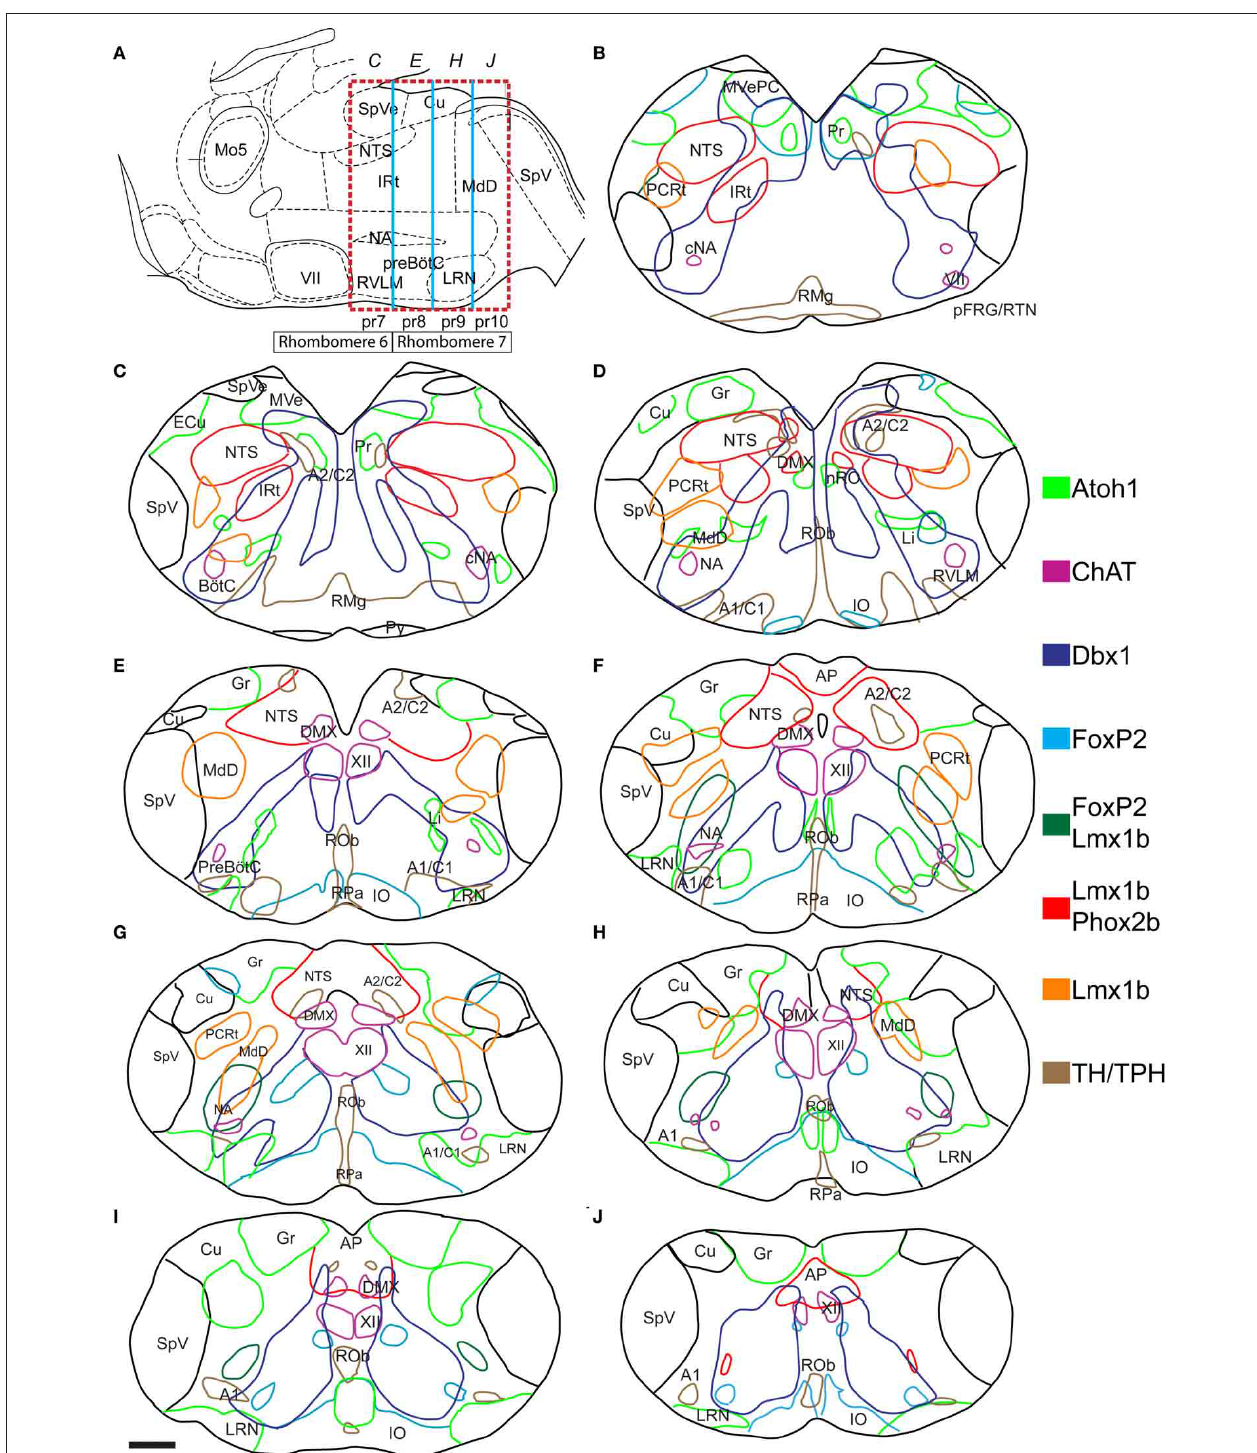
FIGURE 2 | Atlas of reticular formation developmental origin in neonate mouse medulla. (A) Mid-sagittal cartoon showing approximate region of mapping (red dashed box). Boxes below hindbrain indicate rhombomere 6 and 7 boundaries. Blue lines indicate pseudo-rhombomere7–10 boundaries. Italicized letters indicate rostro-caudal position of sections in map. Image modified from Franklin (1997). (B–J) Outlines of medullary sections from